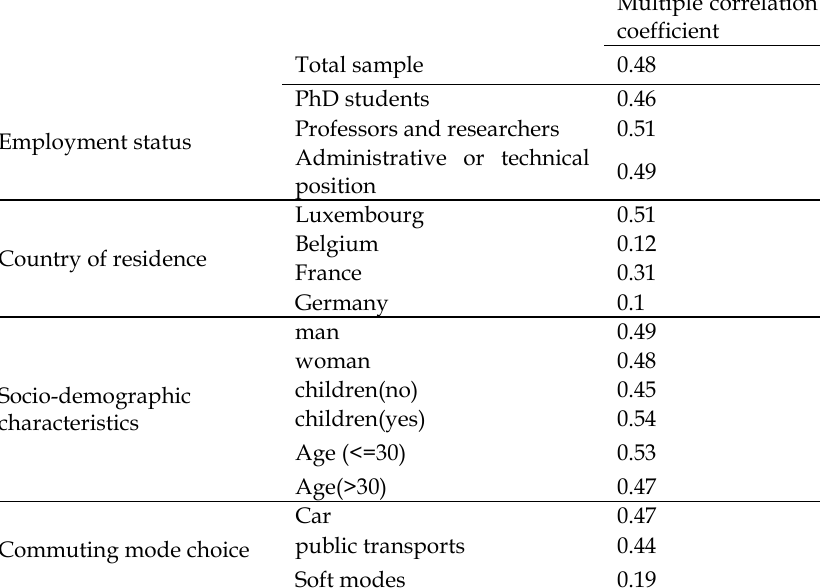
Table 2. Multiple correlation